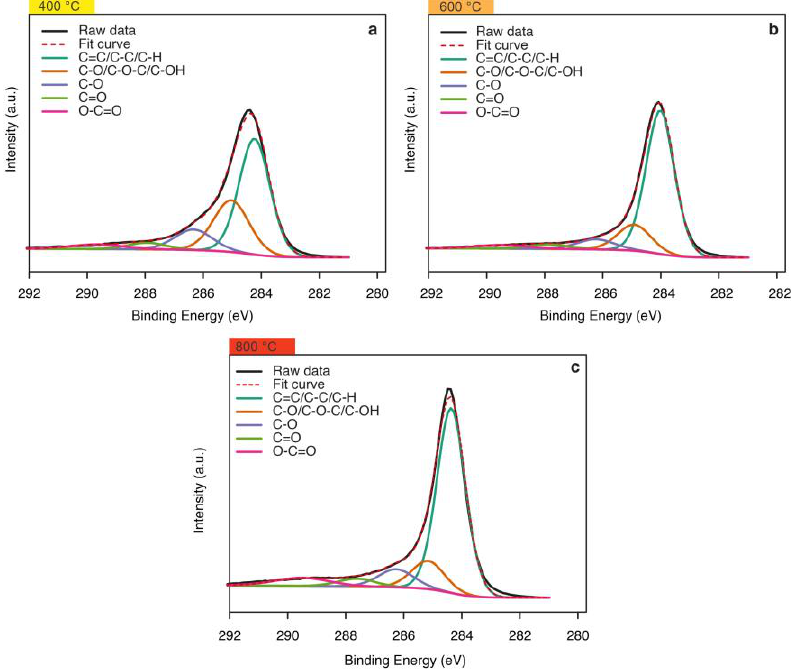
Figure 6. X-ray photoelectron spectroscopy (XPS) of charcoals at temperatures of 400 ( a ), 600 ( b ), and 800 °C ( c ). 800 ◦ C ( c ).